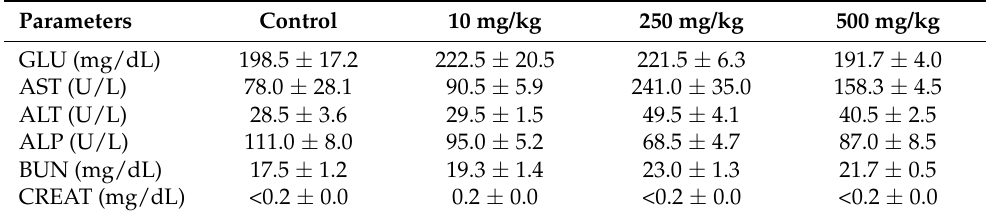
Table 4. Comparison of PsA versus vehicle control-treated hematological biochemical parameters glucose (GLU), aspartate aminotransferase (AST), alanine aminotransferase (ALT), alkaline phos- phatase (ALP), blood urea nitrogen (BUN), and creatinine (CREAT) in female Swiss albino mice. Data shown as mean ± SEM for n = 5/sex/group.